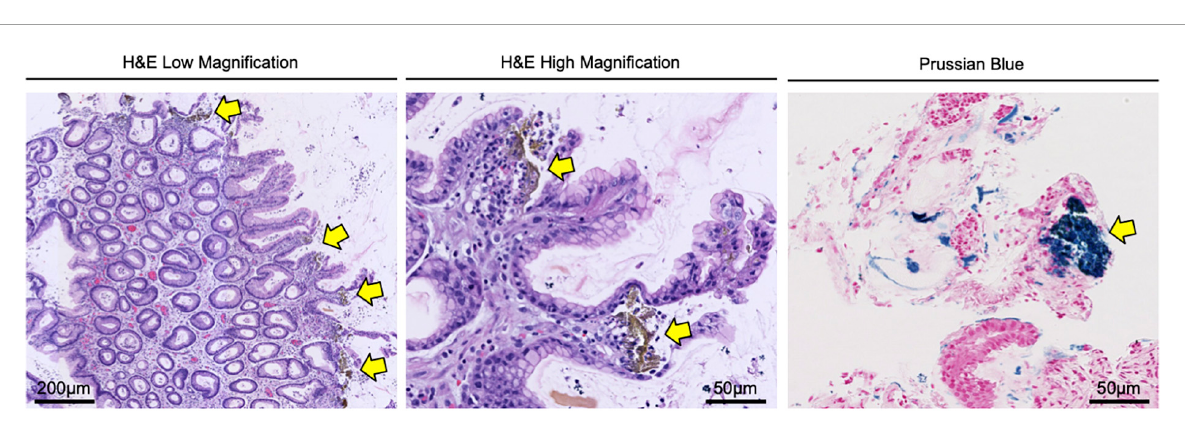
FIGURE2 Gastric biopsy confirming the diagnosis of iron pill gastritis. Gastric lesions were biopsied and stained with H&E, showing inflammation with pits of brown pigment (yellow arrows) consistent with iron gastropathy. Tissues were also stained via Prussian blue, confirming the presence of iron crystals (yellow arrows) in the gastric